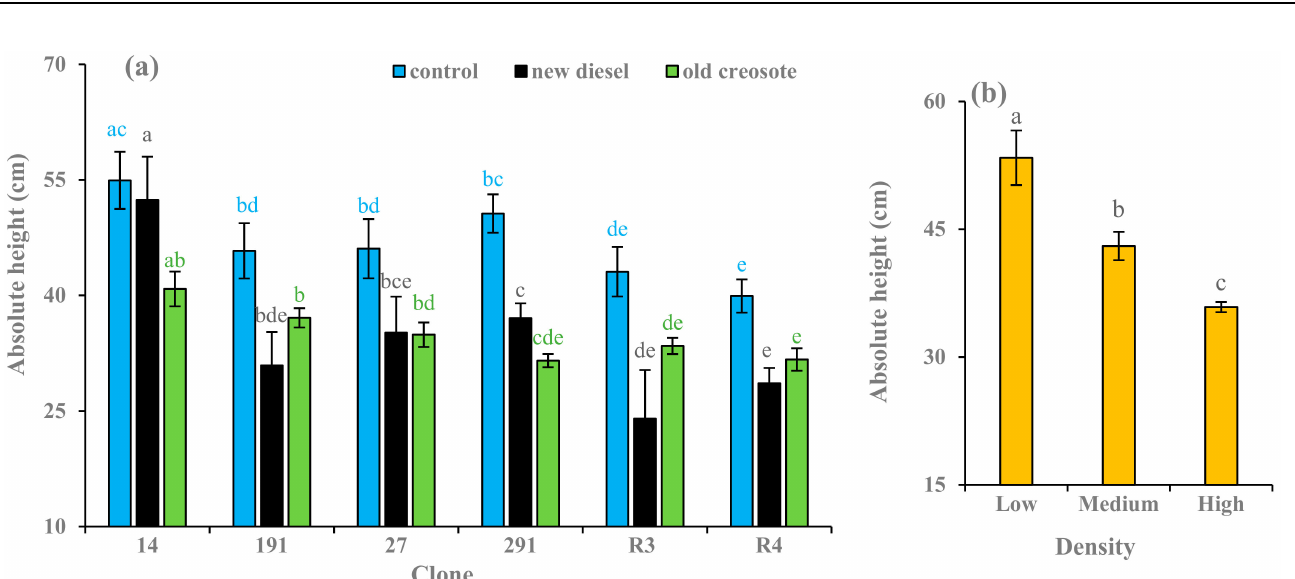
Figure 3. Average ( n = 3) absolute height (cm) of European aspen and hybrid aspen clones grown in different soil treatments ( a ) and plant densities ( b ). Error bar indicates ± standard error (SE). Means between clones followed by the same lower-case letters with the same font color are not significantly different ( p > 0.05). Means between density treatments followed by the same lower-case letters are also not significantly different ( p >